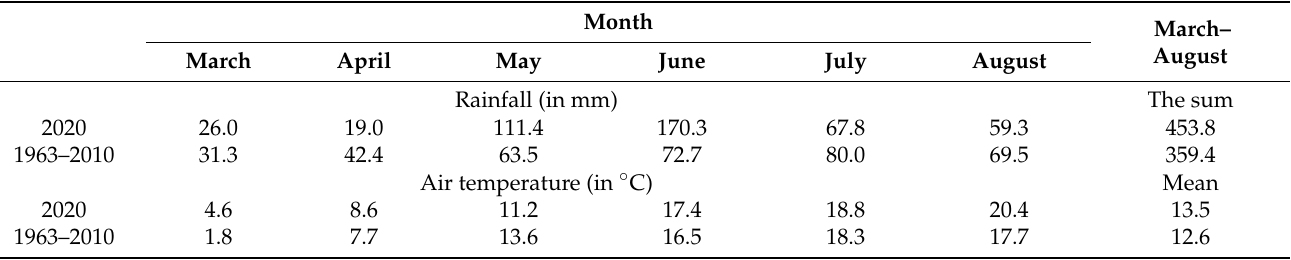
Table 4. Mean air temperature (in ◦ C) and mean precipitation (in mm) during spring wheat-growing season in 2020, including multiyear period